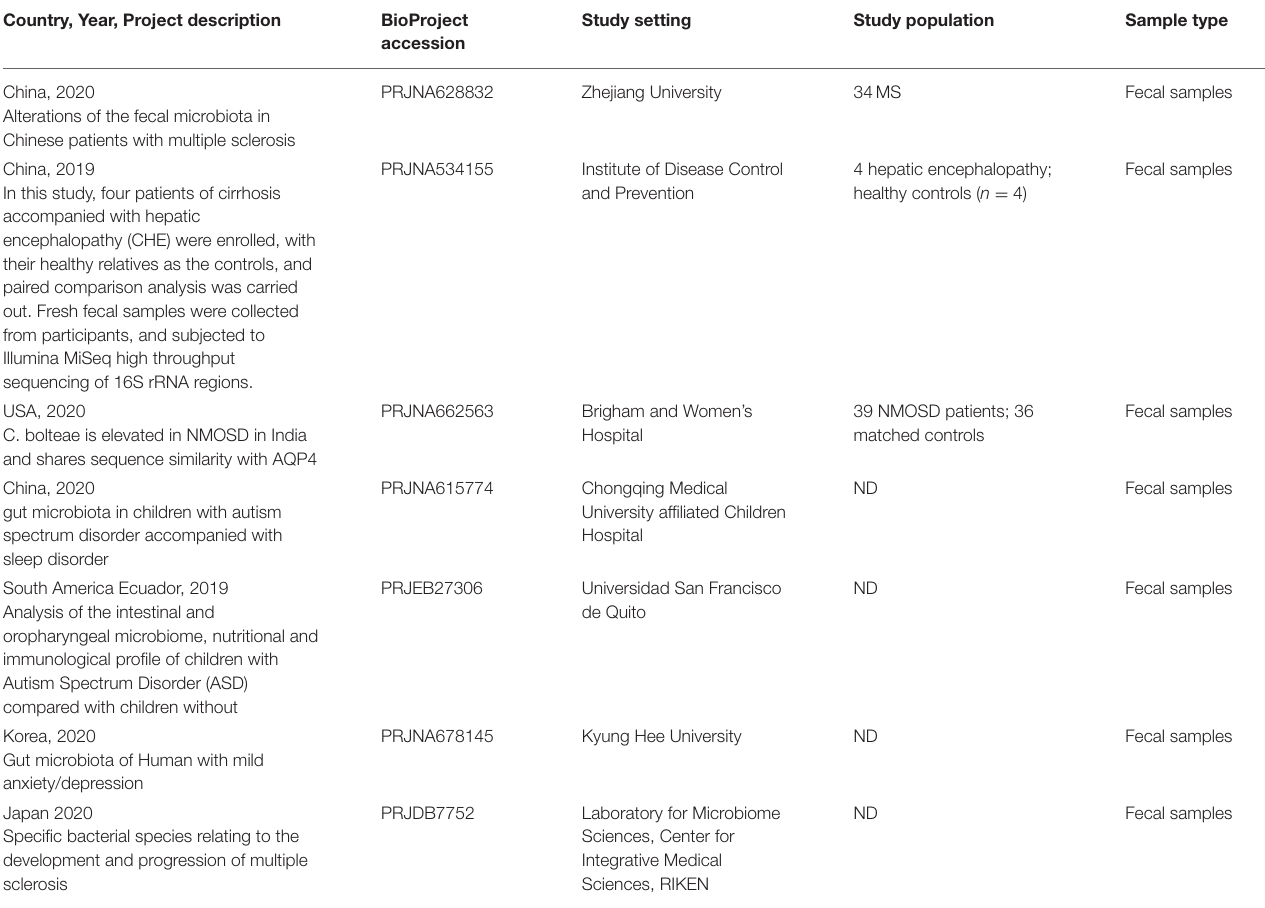
TABLE 1 | Characteristics of studies included in